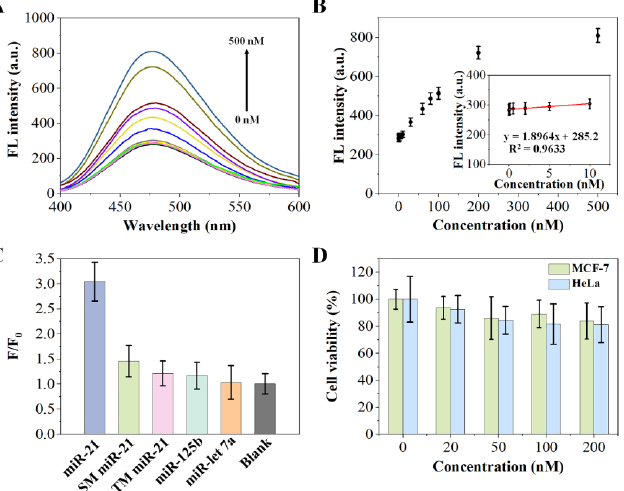
Figure 4. ( A ) Fluorescence response spectra of the YFNP-based assay with different concentrations of miR-21 in the range of 0–500 nM (0, 0.1, 0.5, 2, 5, 10, 30, 60, 80, 100, 200, 500 nM). ( B ) The relationship between the fluorescence intensity of the YFNP at 478 nm and different concentrations of miR- 21 in the range of 0 to 500 nM. Inset: the linear plot of the fluorescence intensity at 478 nm versus the concentration of miR-21 (0 – 10 nM). ( C ) Selectivity assay of responses of the YFNP to miR-21 and its analogues. F was the fluorescence intensity of the YFNP at 478 nm with the addition of different miRNA species, F 0 was the fluorescence intensity of the YFNP at 478 nm without the addition of the miRNA species. miR-21 = SM miR-21 = TM miR-21 = miR-125b = miR-let 7a = 500 nM. ( D ) The cell viability of MCF-7 cells and HeLa cells after 24 h incubation with different concentrations (20, 50, 100, 200 nM) of the YFNP. Error bars indicate the standard deviation of measurements (n = 3).